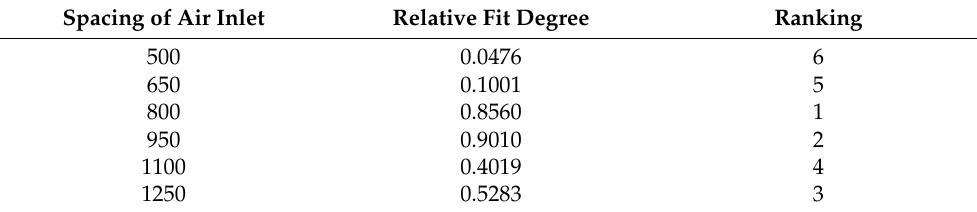
Table 7. Calculation results of TOPSIS evaluation